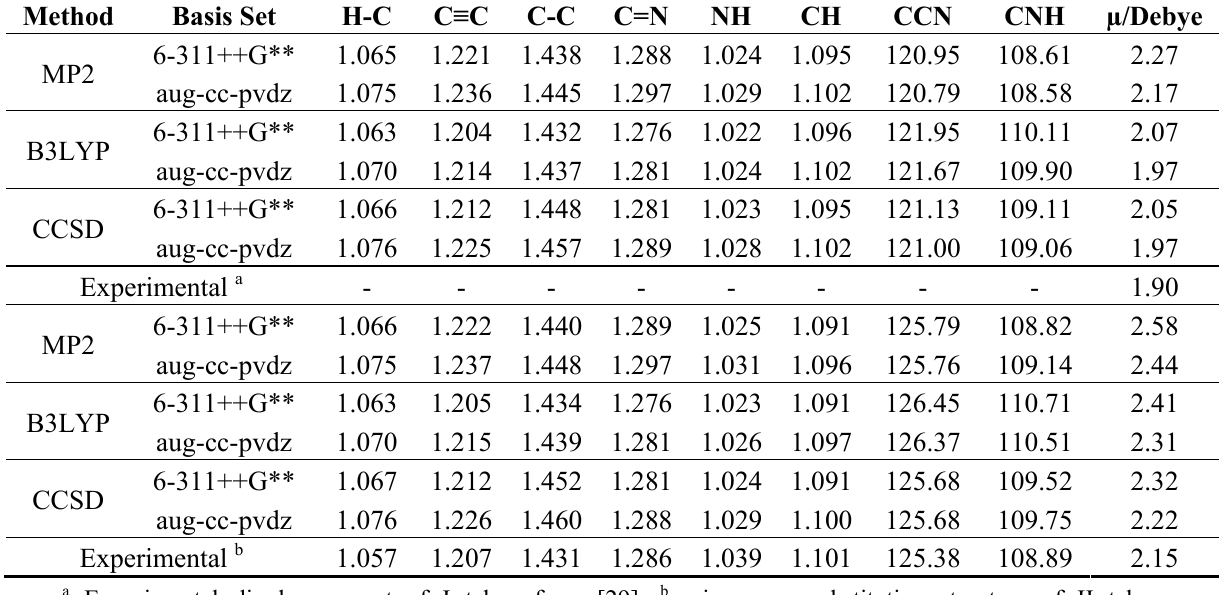
Table 1. The optimized parameters (bond lengths/Å and bond angles/degrees) and dipole moments (μ/Debye) of E-HC≡CCH=NH (I) and Z-HC≡CCH=NH (II) using MP2, B3LYP and CCSD methods with 6-311++G** and aug-cc-pvdz basis sets.